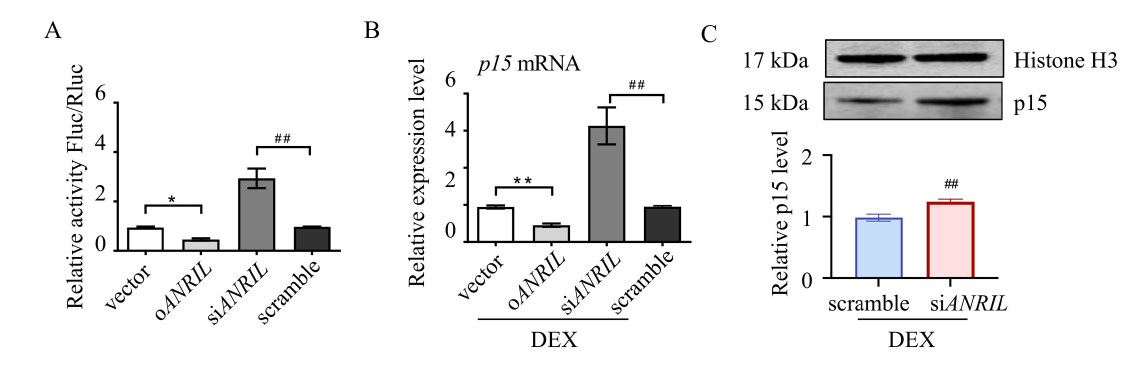
Figure 3. Reciprocal regulation between ANRIL and p15. Mice p15 gene was cloned upstream of the luciferase reporter. Mice ANRIL plasmid or siRNA were co-transfected with luciferase reporter into mouse TM cells. ( A ) The luciferase activity was greatly increased in siANRIL cells compared to scramble. In oANRIL cells, the luciferase activity was suppressed. ( B ) Depletion of ANRIL increased the mRNA level of p15 in TM cells, and overexpression of ANRIL inhibited the expression of p15, as measured by real-time PCR. ( C ) Depletion of ANRIL increased the p15 protein level in TM cells. Notes: n = 6 per group; oANRIL = ANRIL overexpression; siANRIL = ANRIL knock down; DEX = dexamethasone; * p < 0.05 compared with vector; ** p < 0.01 compared with vector; ## p < 0.01 compared with scramble